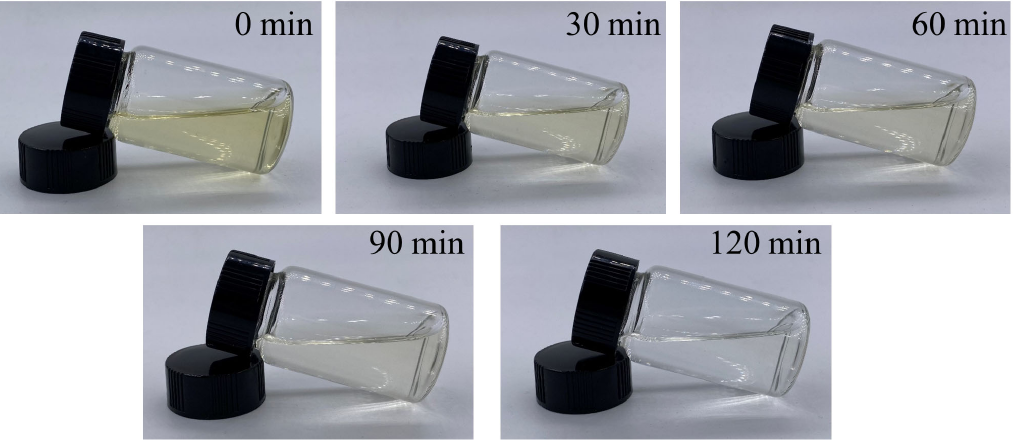
Figure 6. Photographs of colorant solutions before and after adsorption for 30–120 min by BBC-HAP (dosage, 0.75 mg/mL; temperature, 300 K; pH, 7; and initial colorant concentration, 250 mg/L).